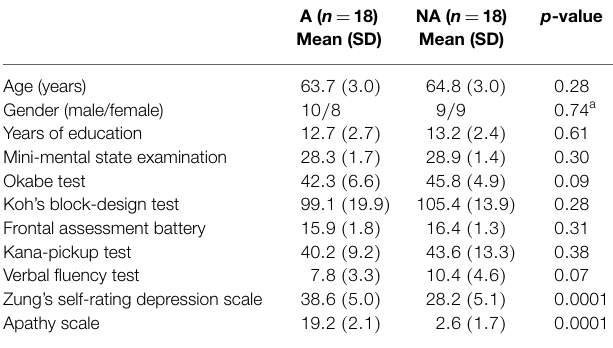
TABLE 1 | Demographic characteristics and neuropsychiatric test scores